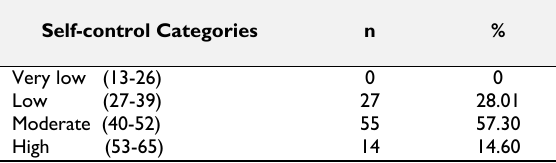
Table 2 D escriptive statistics for the older adults’ level of self -control (N = 96) Self-control